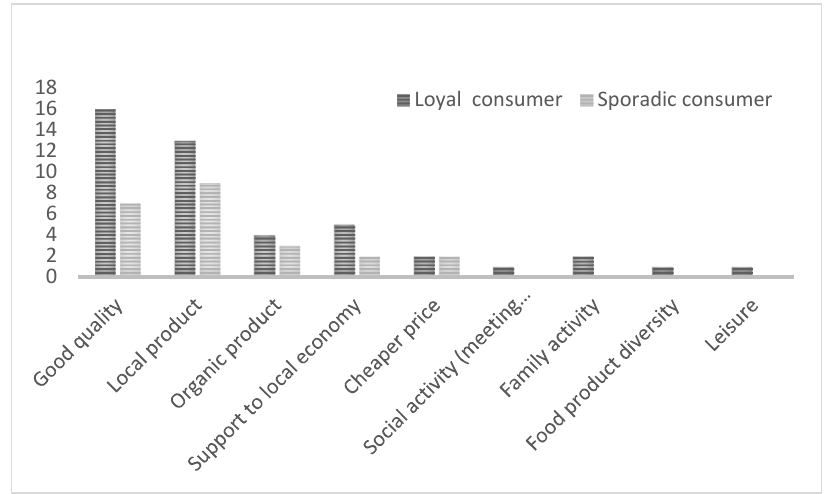
Figure 5. Consumer’s motivation for attending the food markets. Source: The authors.